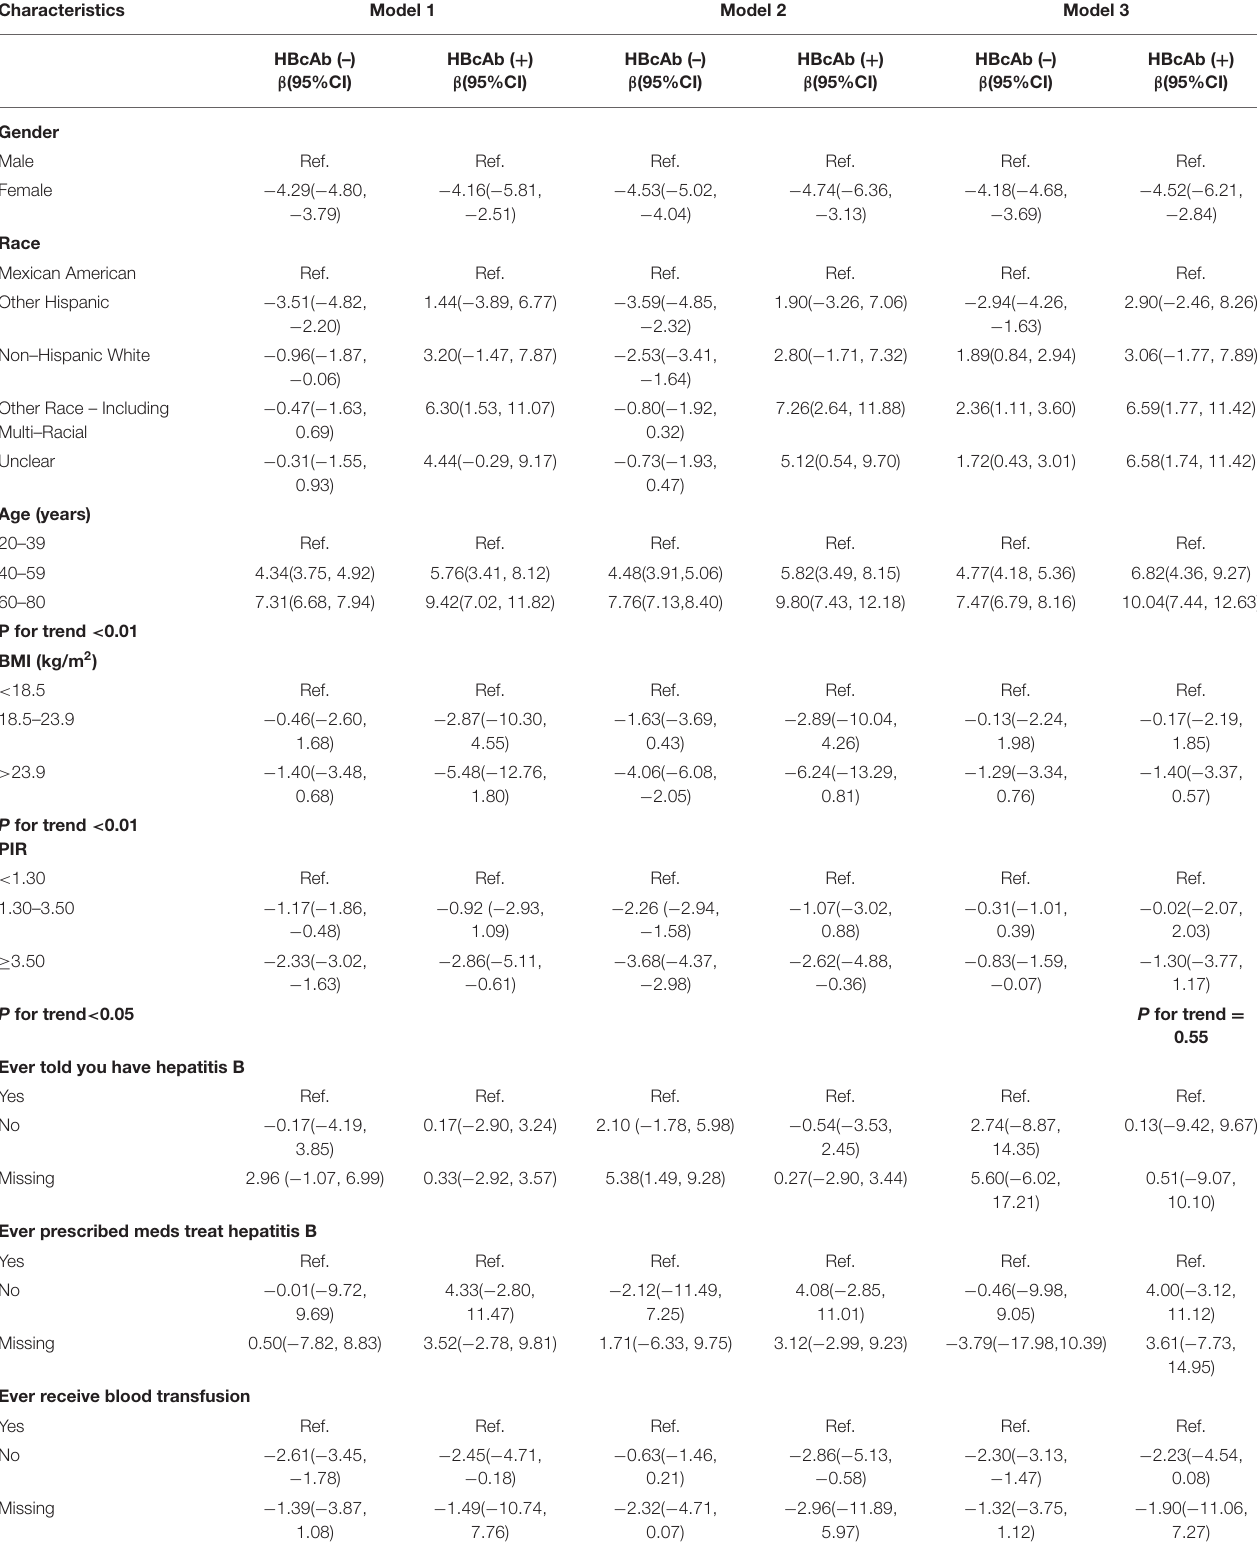
TABLE 2 | Associations between hypothesized risk factors and blood lead levels